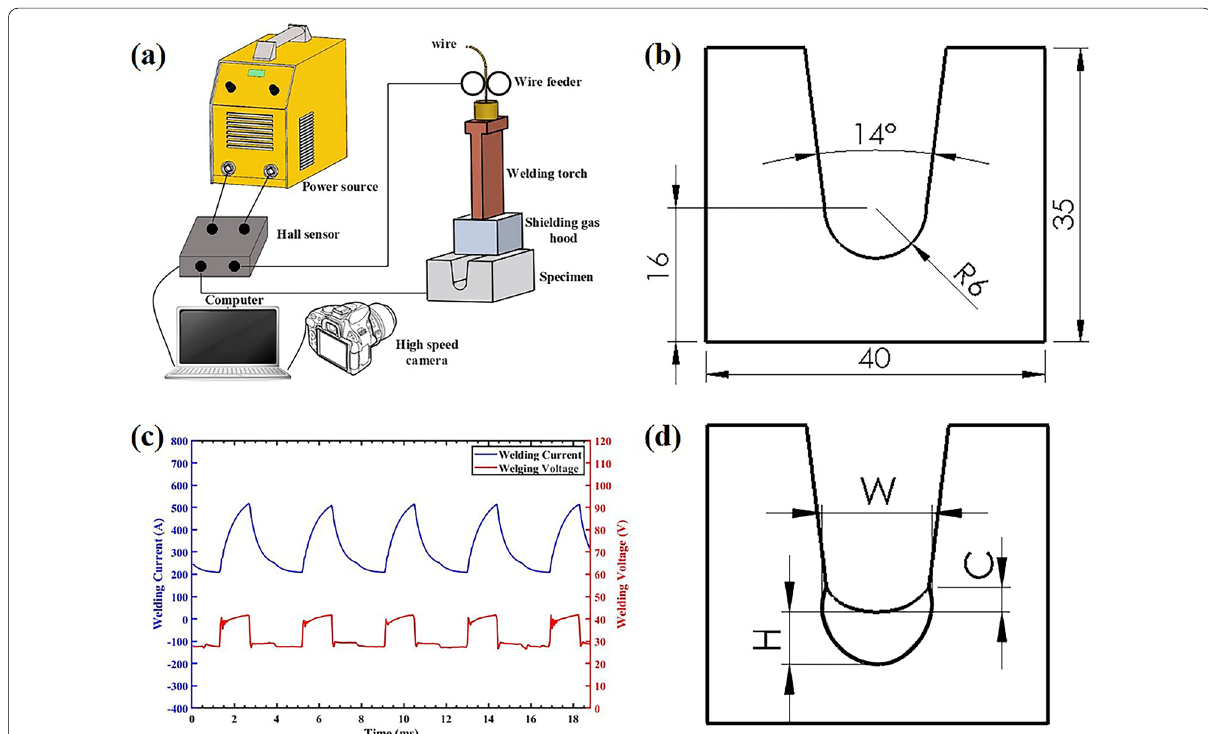
Figure 1 a Schematic diagram of welding experiment system setup, b cross section dimension of specimen and its narrow-gap groove, c Welding current and arc voltage waveforms, d characterization for first-pass weld bead of NG-GMAW